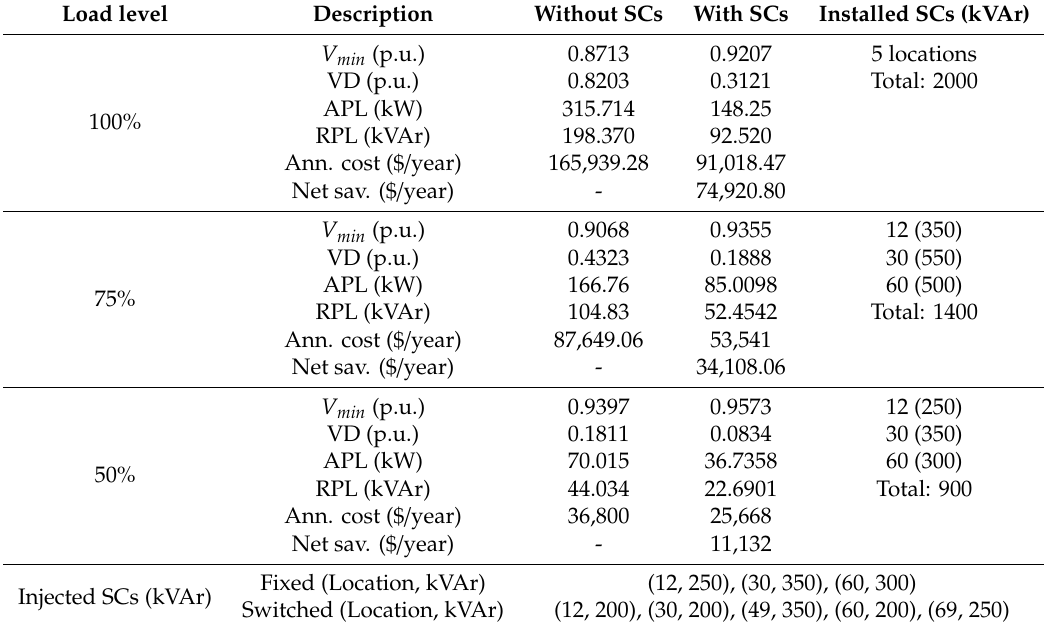
Table 9. Optimal results of PODESCA for the 85-bus system considering di ff erent load levels.